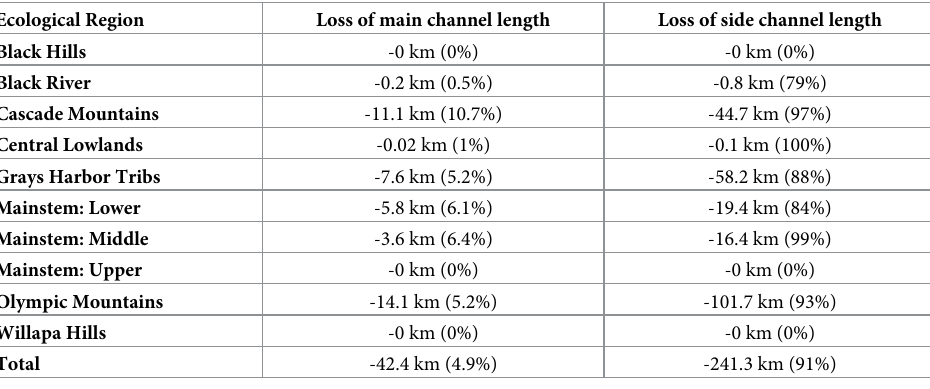
Table 4. Changes in channel